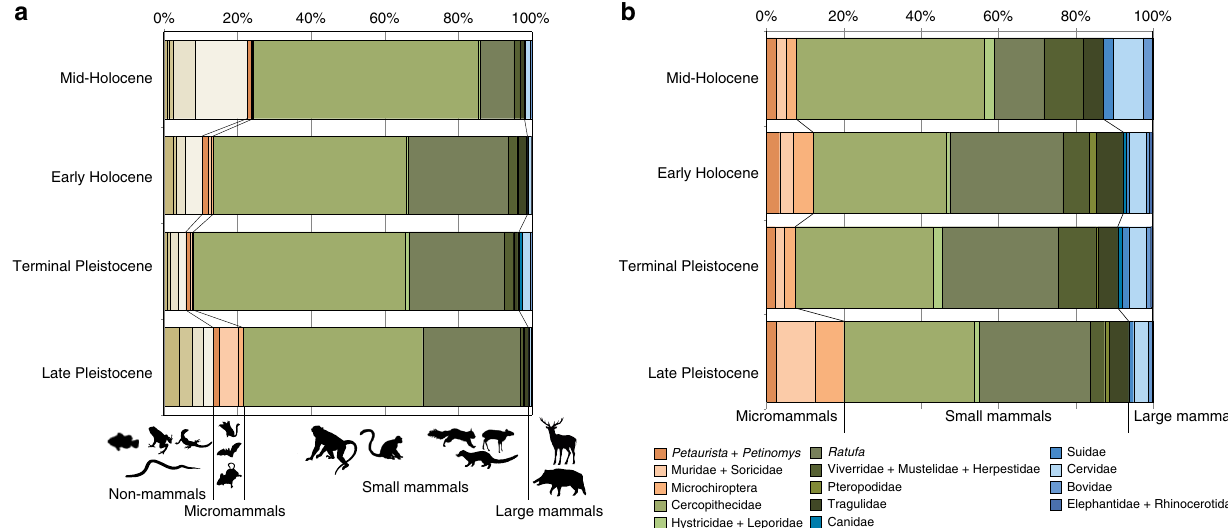
Fig. 3 Animal taxa identi fi ed in Fa-Hien Lena. Distribution of animal taxa identi fi ed in the different occupational phases of Fa-Hien Lena based on the number of identi fi ed specimens (NISP, a ) and the minimum number of individuals (MNI, b ). (Brown: non-mammals; orange: micromammals; green: small mammals; blue: large